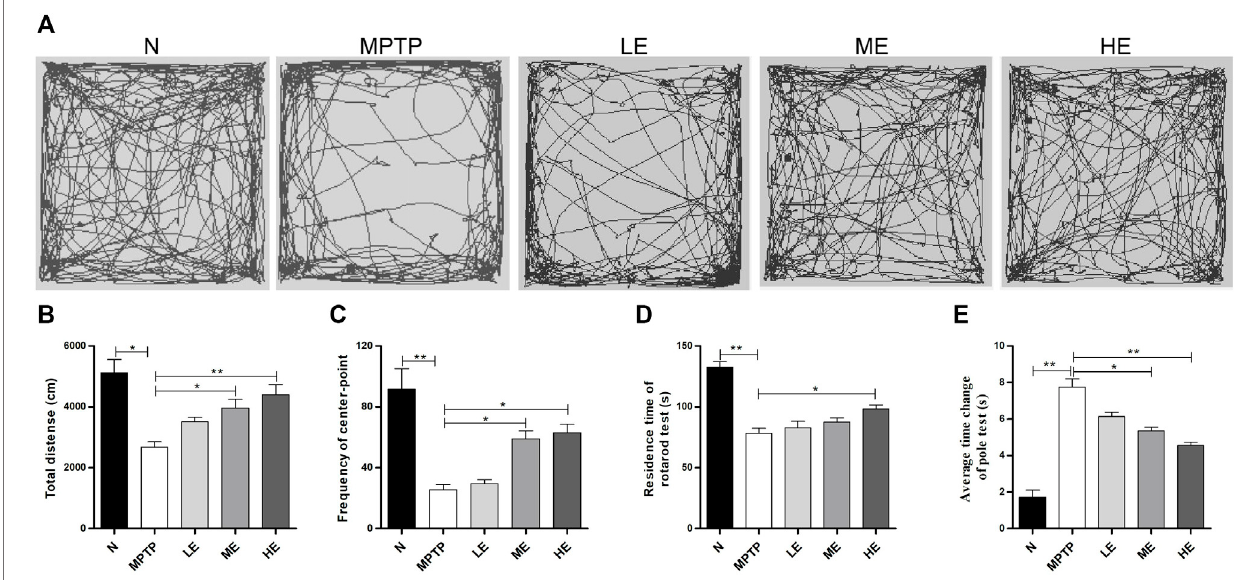
FIGURE 1 | Protective effect of ECH against MPTP-induced behavioral dysfunction. (A) The autonomous trajectory map of mice in the open fi eld test. (B) Total distance traveled of mice in the open fi eld test. (C) The number of line crossings of mice in the open fi eld test (D) The residence time of mice in the rotarod test. (E) The average time change of the pole test. N: normal; MPTP: MPTP-induced mice; LE: MPTP + 10 mg/kg/d ECH; ME: MPTP + 20 mg/kg/d ECH; HE: MPTP + 30 mg/kg/d ECH. Values are presented as the mean ± SEM. * p < 0.05, ** p < 0.01.